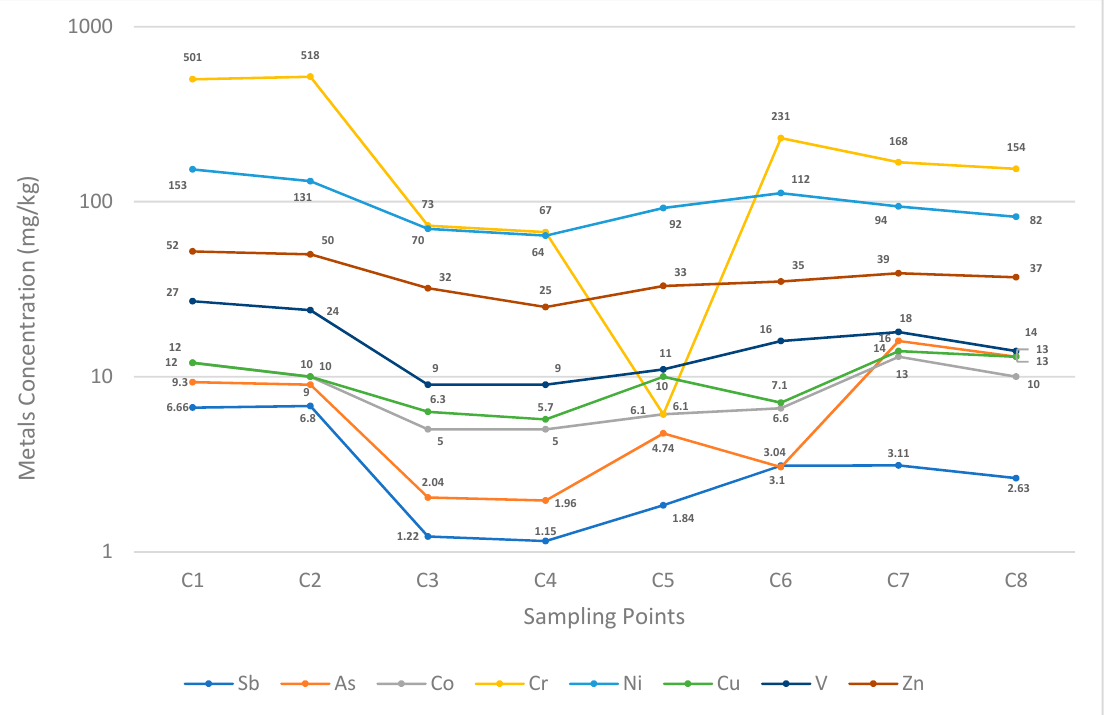
Figure 5. Location of sampling points: effective sampling mesh.